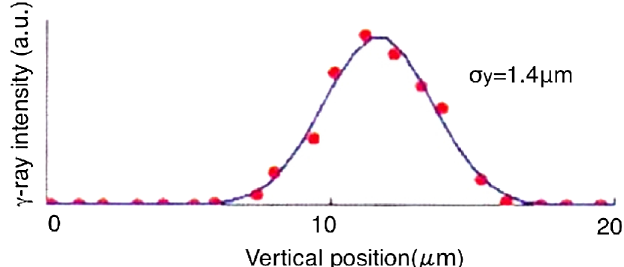
FIG. 15. The vertical beam size measurement with the wire scanner at the downstream of the focus